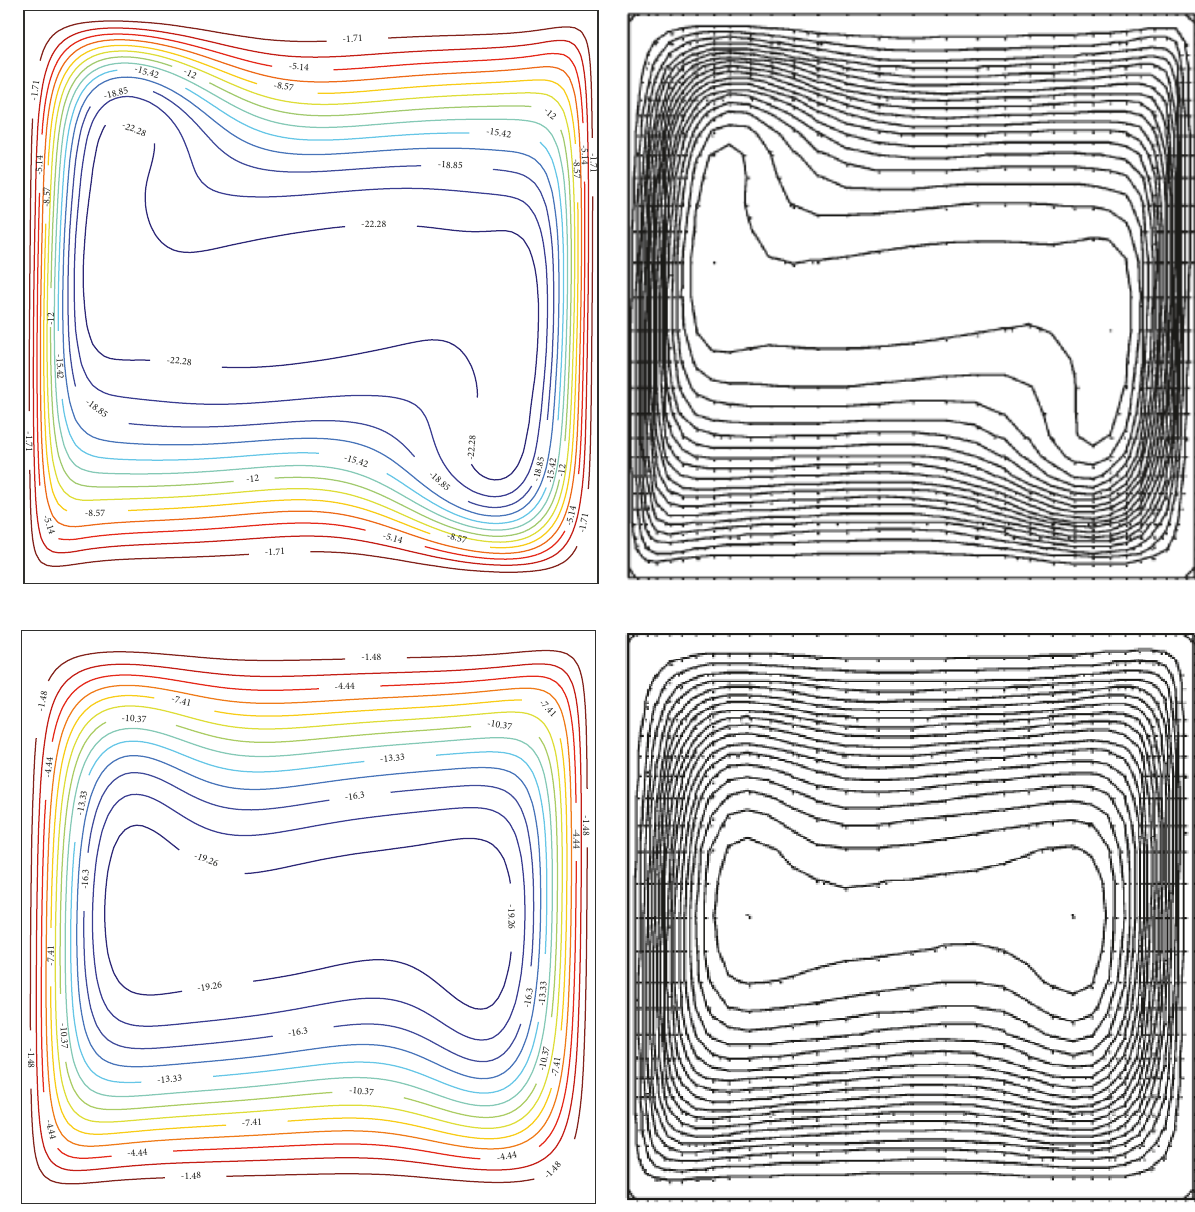
Figure 3: Comparison of computed streamlines with Aydin and Pop [10] results for continuous heating left wall at 𝜙 = 0 , 𝑅𝑎 = 10 6 , 𝑃𝑟 = 0.71 , 𝐾 = 0, 2 .